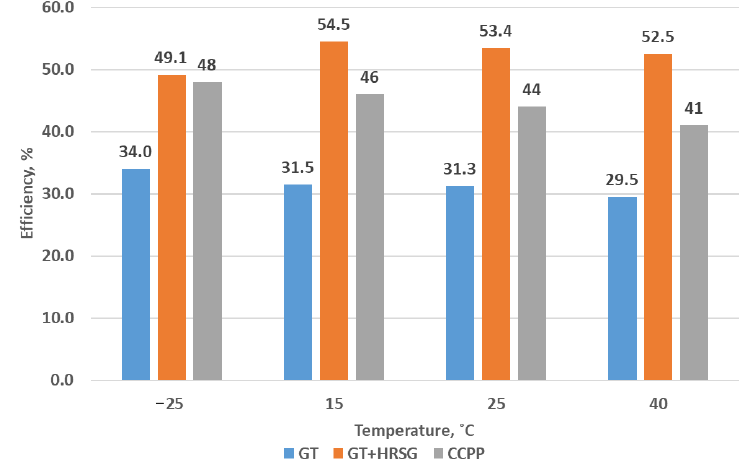
Figure 10. Efficiency of the considered schemes depending on temperature.